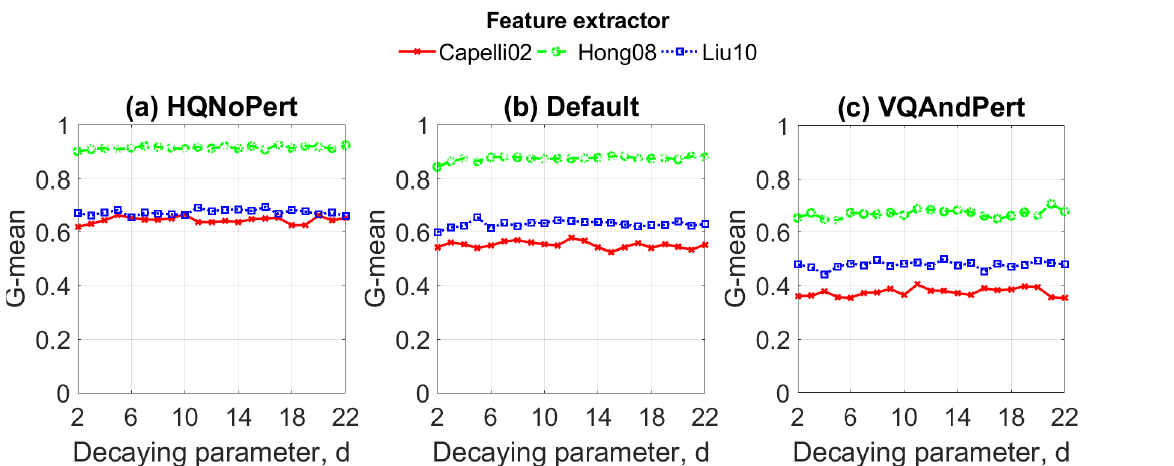
Figure 9. Graphics of the obtained G-mean against the decaying parameter of the decay weighted ELM (DW-ELM) for each feature extractor and database during the validation stage. The number of hidden neurons and regularization parameter are adopted from the optimal weighted